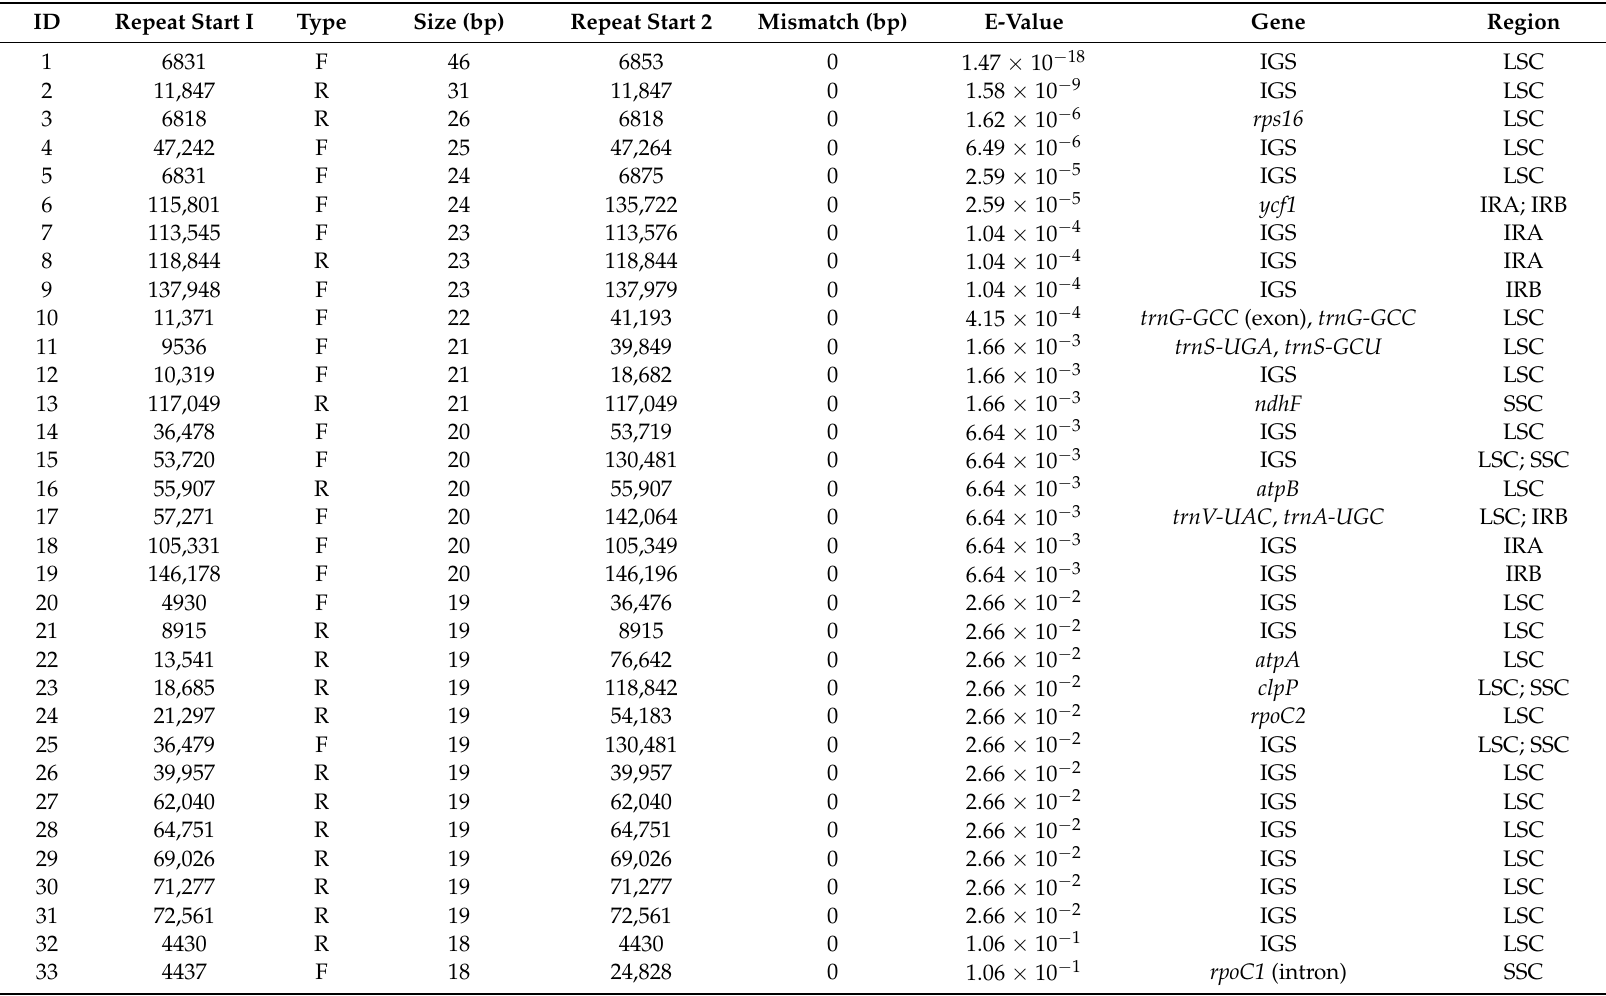
Table 5. Long repeat sequence in the Q. acutissima chloroplast